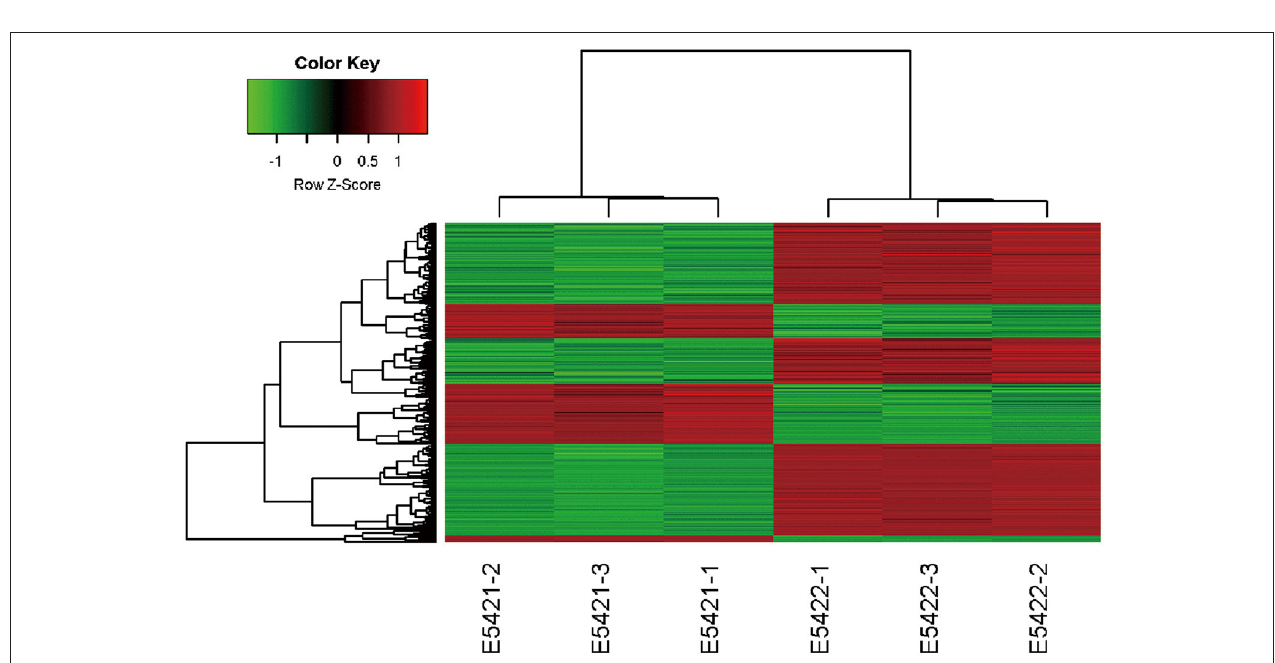
FIGURE 2 | derived as percentages of Annexin V-PE positive cells. (D) Cell cycle was assessed in A549 cells using flow cytometry after transfection with the indicated shRNAs. Representative flow-cytograms are shown, as well as diagrams quantifying cell fractions in the G0/G1, S, and G2/M phases. (E) Differential expression of apoptosis regulatory proteins associated with IARS2 knockdown. Western blotting analysis was performed to compare expression levels of various apoptosis-related proteins between the IARS2 and control groups. * p < 0.05 compared with the control group.